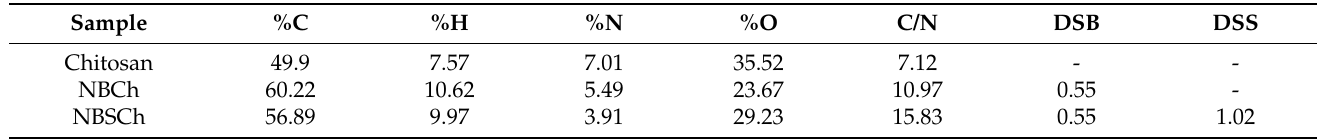
Table 1. Elemental analysis of Chitosan, NBCh and NBSCh performed on CHN/O analyzer for DSB and DSS calculation.